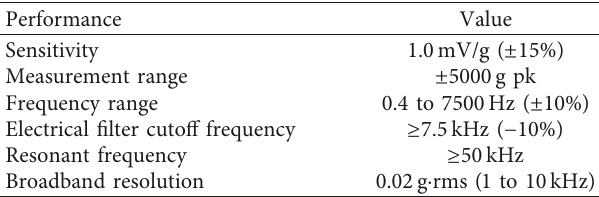
Table 1: The parameters of the